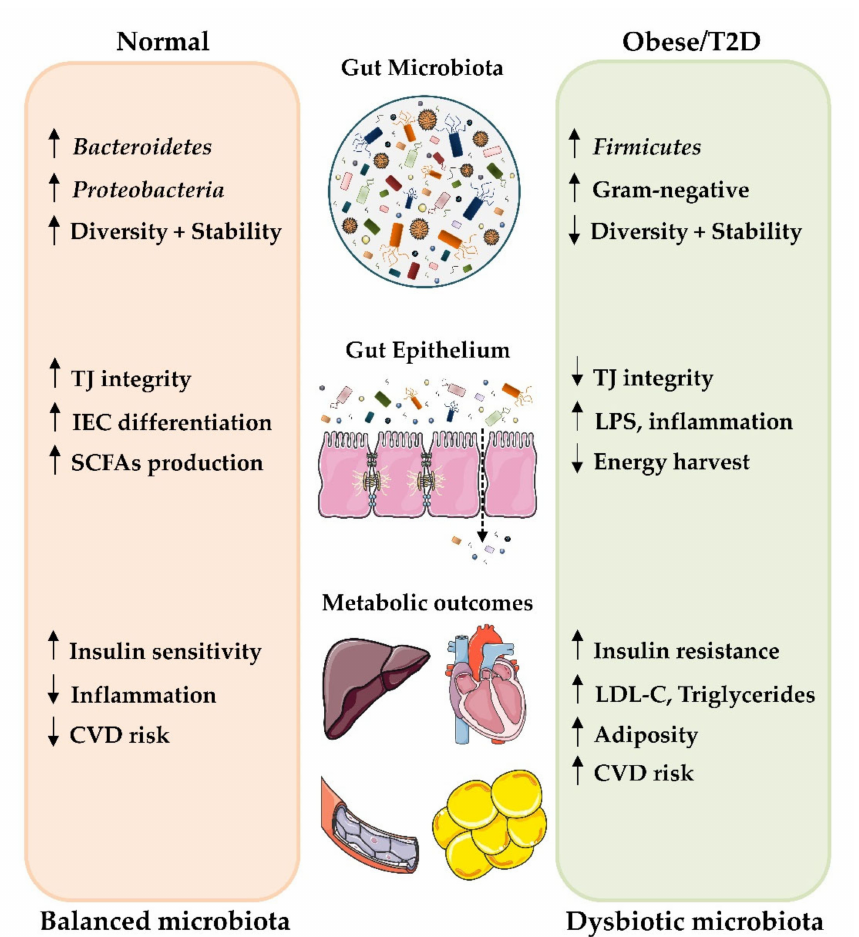
Figure 2. Role of gut microbiota in the development of obesity and T2D, including some of the mechanisms thought to contribute to alterations of the host metabolic state. Up and down arrows indicate an increase and decrease, respectively. Abbreviations: IEC, intestinal epithelial cells; LPS, lipopolysaccharide; LDL-C, low-density lipoproteins-cholesterol; SCFAs, short-chain fatty acids; CVD, cardiovascular disease and TJ, tight